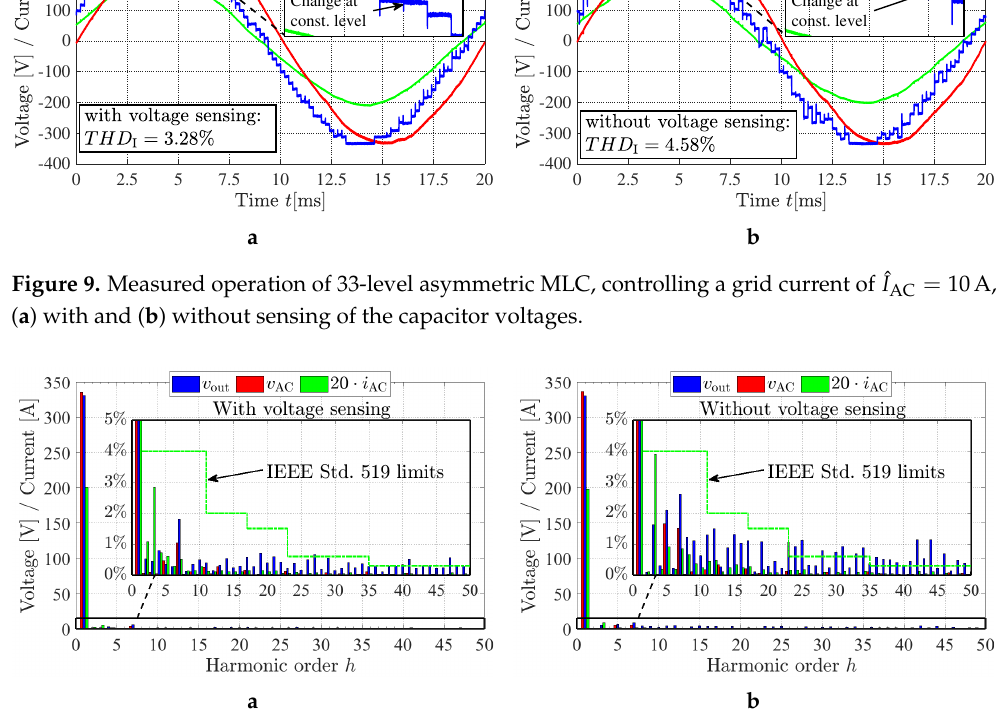
Figure 10. Harmonic components of measured voltage and current waveforms given in Figure 9, ( a ) with and ( b ) without sensing of the capacitor